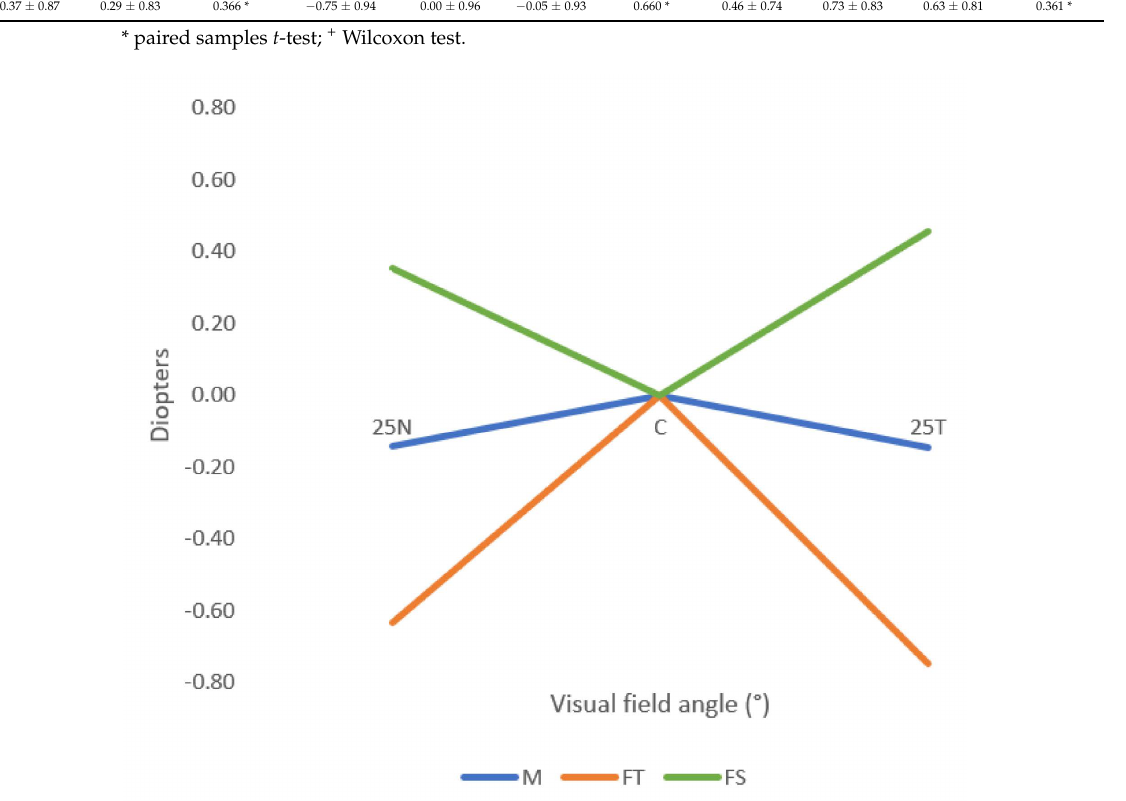
Figure 4. Mean values of the relative spherical equivalent (M), the sagittal focal (FS) and the tangential focal (FT), without any correction (naked eye condition). 25N: 25 ◦ eccentricity at nasal retina, 25T: 25 ◦ eccentricity at temporal retina. Standard deviation is not shown for clarity and can be consulted in Table